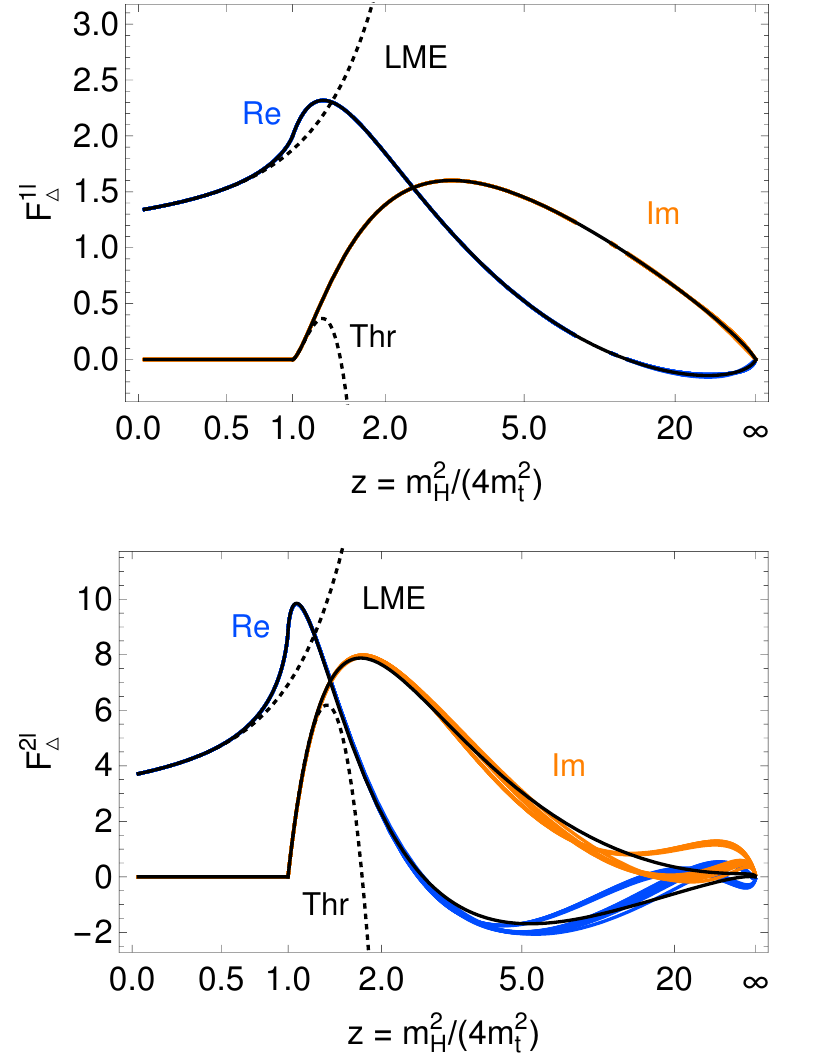
Figure 4 . We show the same comparison as in (cid:12)gure 3 but for Pad(cid:19)e approximants based on the LME and the threshold expansion. Only [5/2], [4/3], [3/4] and [2/5] approximants were constructed at LO and only [4/2], [3/3] and [2/4] approximants were constructed at